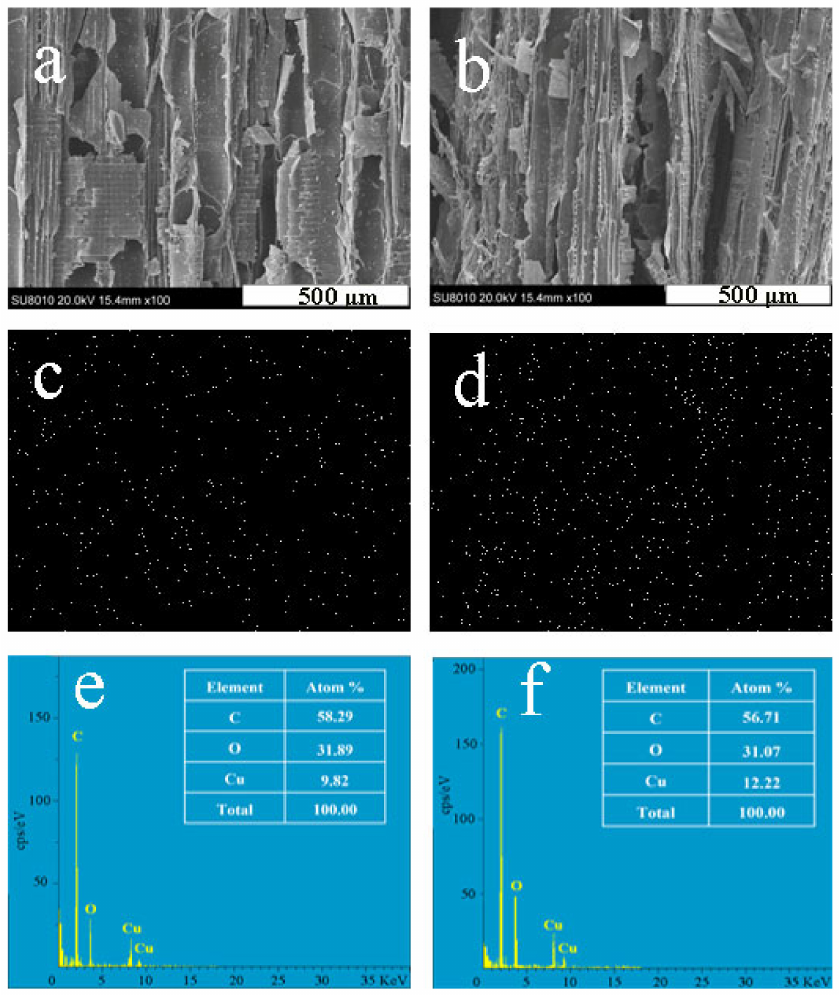
Figure 5. ( a , b ) SEM images, ( c , d ) copper elemental maps in the wood fiber mats (( c ) radial section and ( d ) tangential section), and ( e , f ) EDS spectra and atomic percentage of each element (inset).